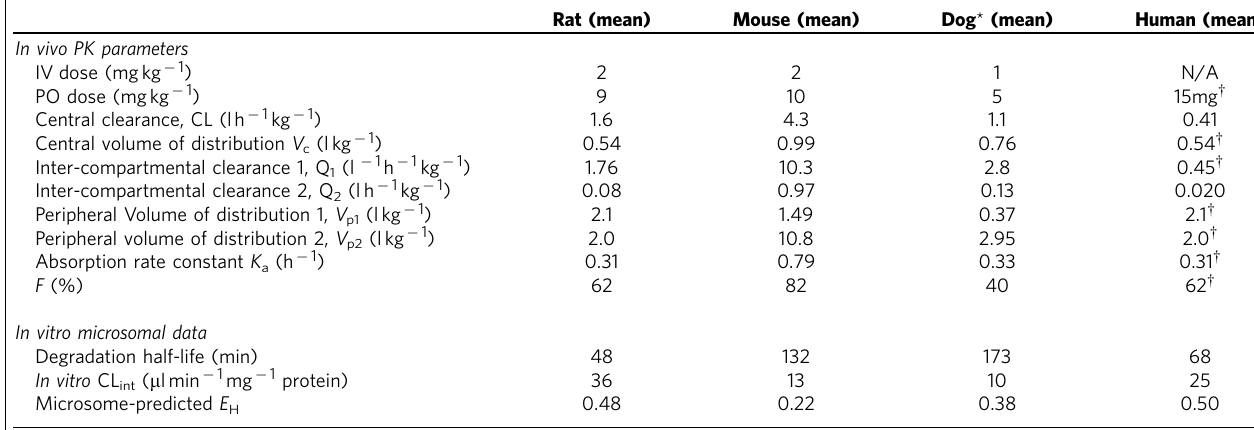
*Supplementary Methods and Supplementary Table 9 in Supporting Information. w On the basis of allometric scaling from rat parameters.